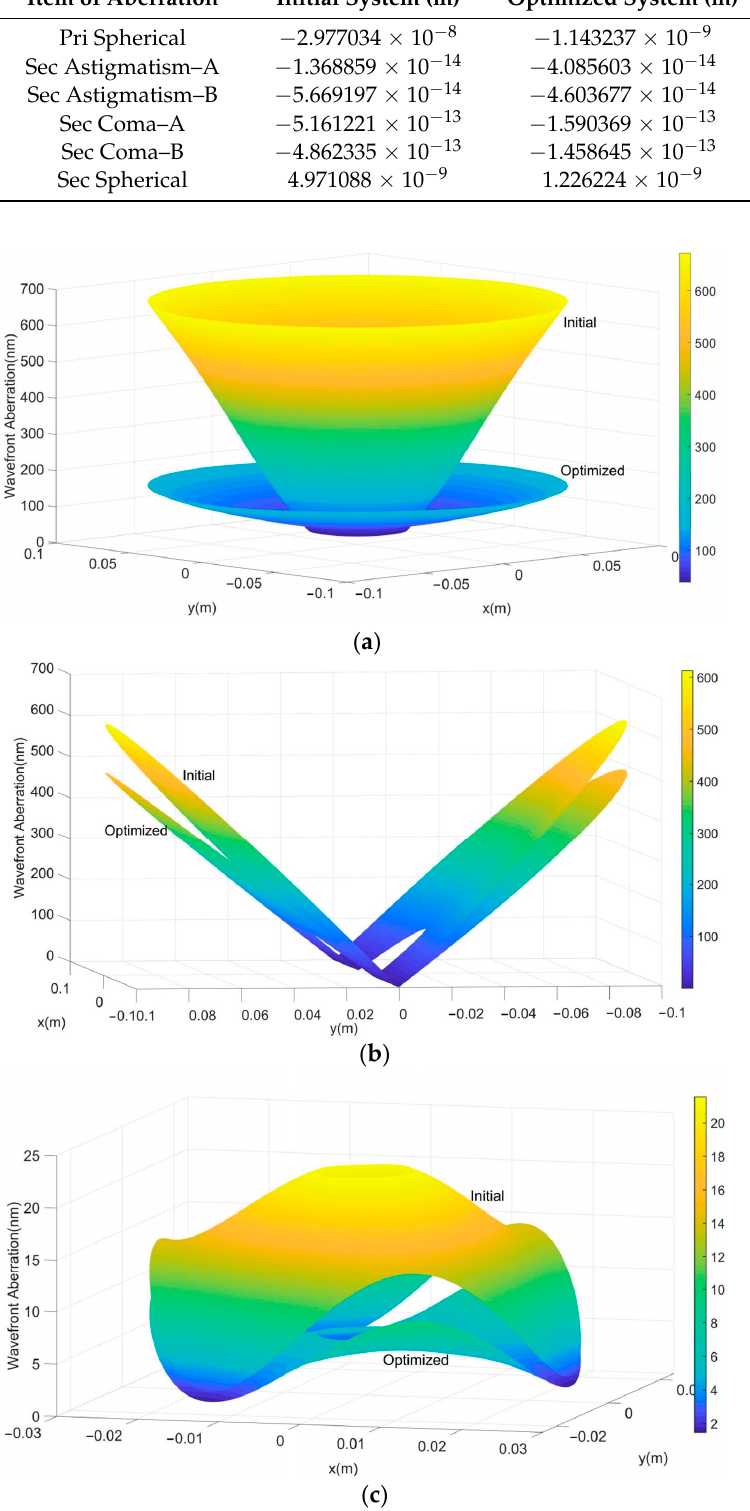
Figure 16. Wavefront aberration diagrams of the initial and optimized mirrors. ( a ) The primary mirror in the vertical optical axis; ( b ) The primary mirror in the horizontal optical axis. For clarity, the absolute value of the aberration is taken; ( c ) The secondary mirror in the vertical optical axis.